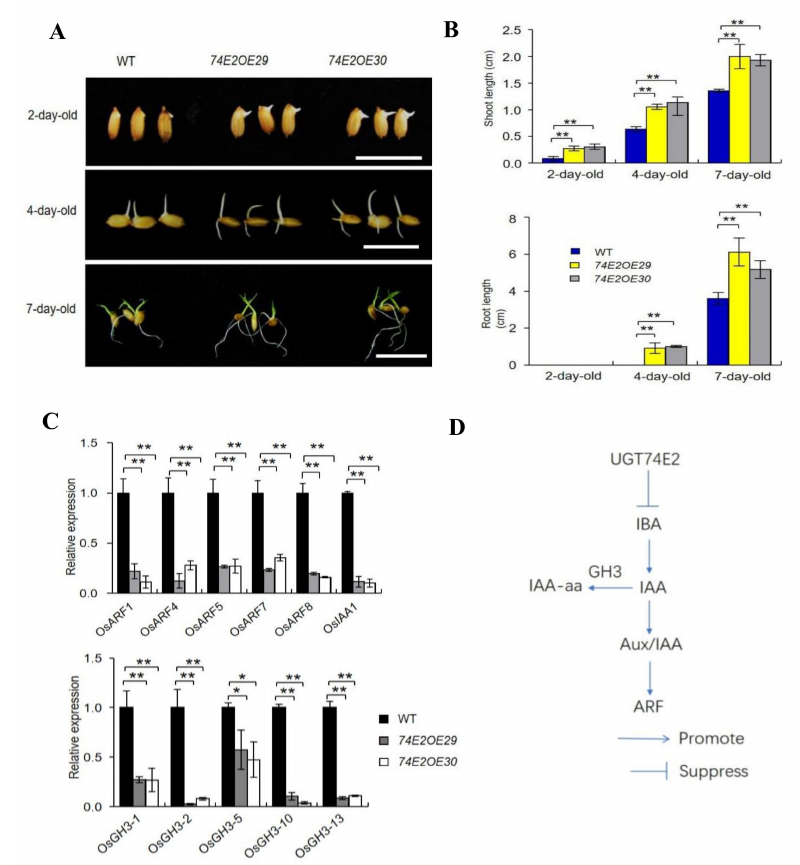
Figure 2. UGT74E2 a ff ected the seed germination and postgermination growth of the transgenic plants. ( A ) Seed germination and postgermination growth of UGT74E2 transgenic plants. Here, at least 30 seeds were observed for each line (bars = 3 cm). ( B ) Shoot and root lengths of UGT74E2 overexpression lines for 2, 4, and 7 days. Bars represent standard deviation of at least 10 seedlings. ( C ) Expression of auxin signaling pathway genes in seven-day-old UGT74E2 -overexpressed rice plants compared to WT. Transcript levels were normalized to the mRNA levels of OsActin . Data shown are means ± SD. Student’s t -test was performed (* p < 0.05, ** p < 0.01). Experiments were conducted for three